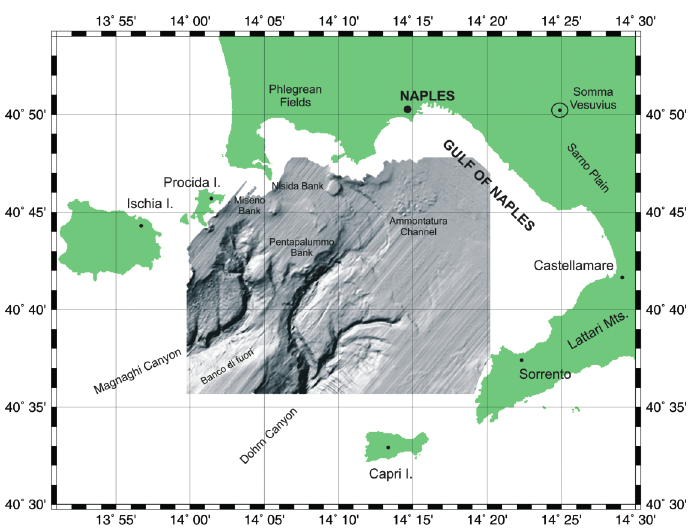
Fig. 1. Sketch map showing the location of the study area and main morphological lineaments in the Gulf of Naples reported from Multibeam bathymetry recorded by CNR-IAMC Geomare Institute (Aiello et al .,